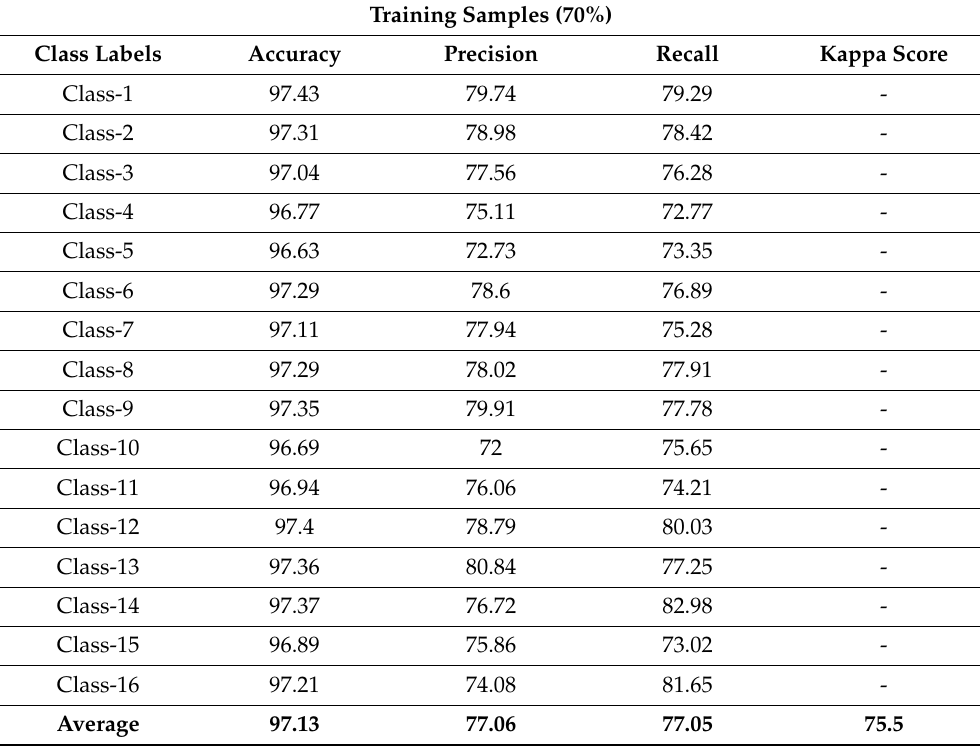
Table 5. Result analysis of the SSODTL-CC technique with distinct classes under 70% of training